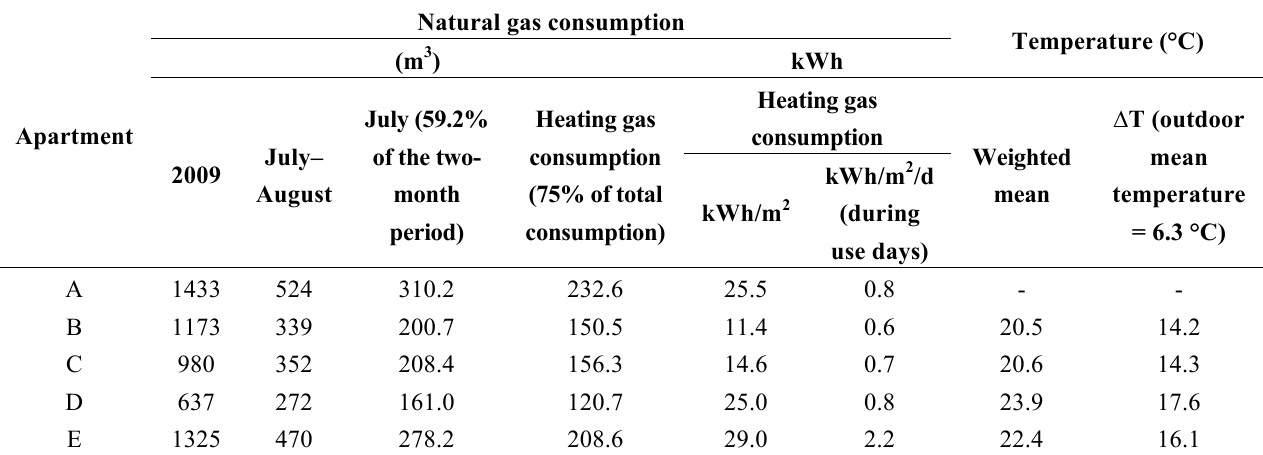
Table 7. Natural gas annual consumption during 2009 in apartments on Floor 11. Weighted indoor mean temperature and ∆ T indoor-outdoor temperature